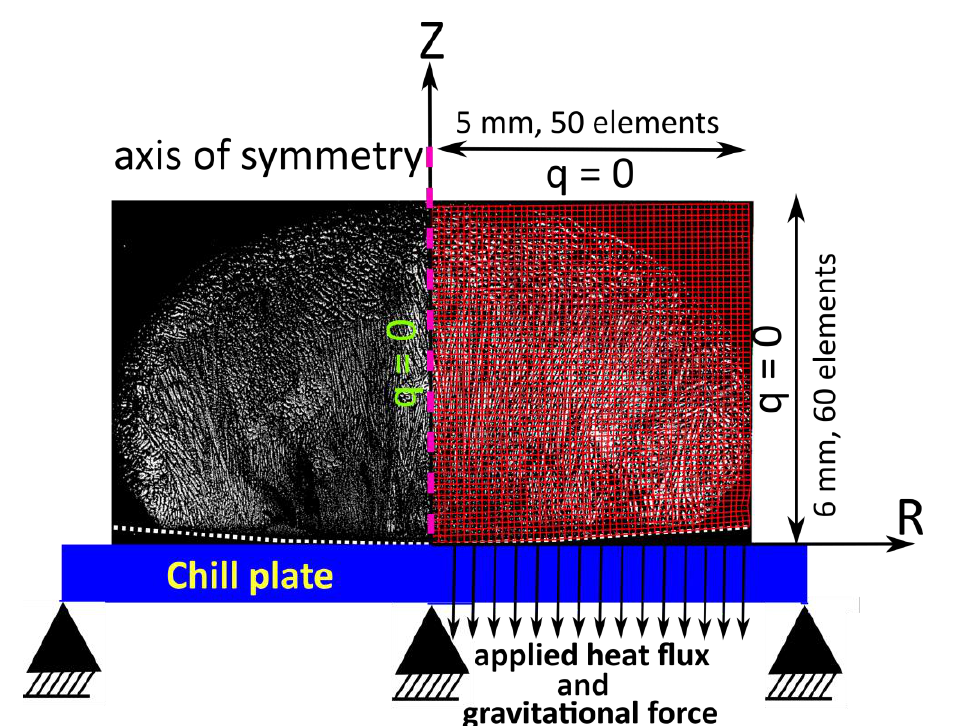
Figure 1. Cross section of the droplet showing the deformed simulation domain after solidification (red mesh) superimposed on the real solidified droplet.